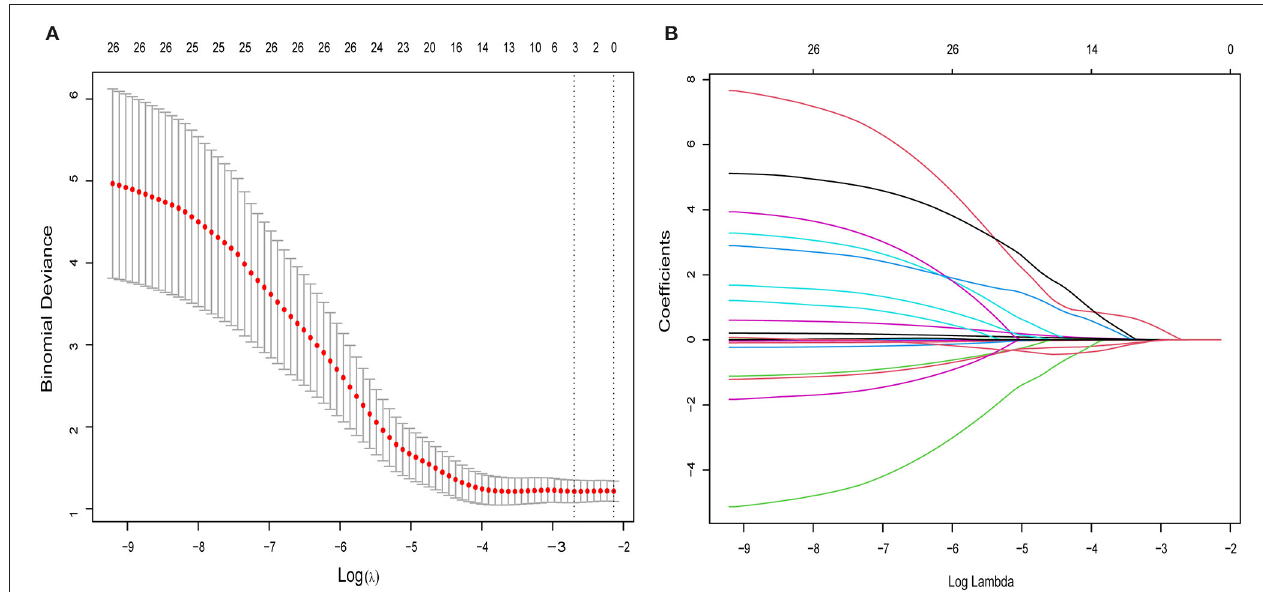
FIGURE 1 | Selection of cytokines, demographic, and clinical features using the LASSO binary logistic regression model. (A) Optimal parameter (lambda) selection in the LASSO model using 10-fold cross-validation via minimum criteria. The partial likelihood deviance (binomial deviance) curve was plotted vs. log (lambda). Dotted vertical lines were drawn at the optimal values by using the minimum criteria and 1 SE of the minimum criteria (the 1-SE criteria). (B) LASSO coefficient profiles of the 26 features. A coefficient profile plot was produced against the log (lambda) sequence. A vertical line was drawn at the value selected using 5-fold cross-validation, where optimal lambda resulted in five features with non-zero coefficients. LASSO, least absolute shrinkage and selection operator.